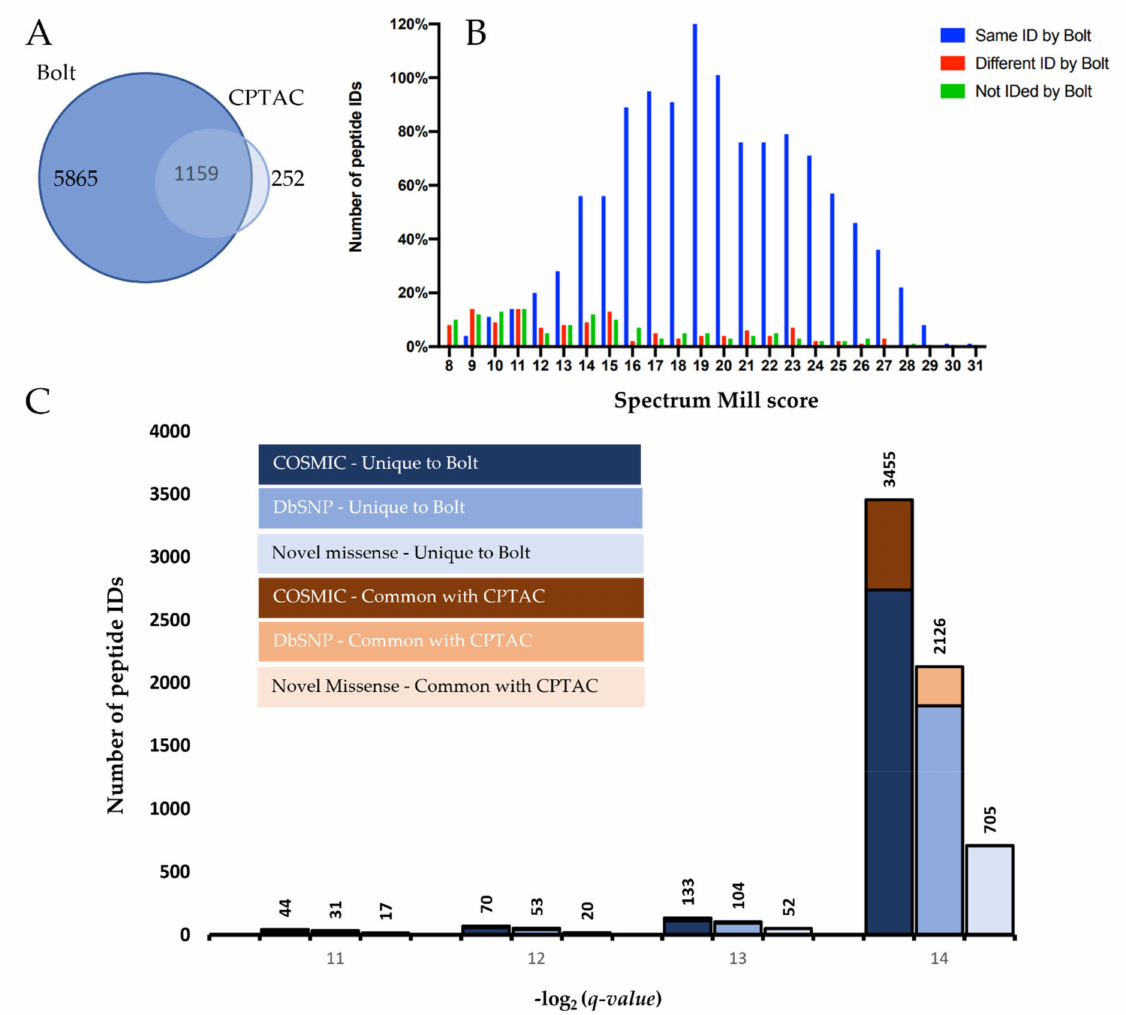
Figure 2. Comparing Bolt and CPTAC pipeline’s variant peptide IDs. ( A ) Venn diagram comparing the overall results between Bolt and CPTAC. ( B ) Spectrum Mill score distribution for the CPTAC’s peptide IDs that were also found by Bolt (blue), the peptide IDs that were matched to different spectra by Bolt (red) and the peptide IDs that were not reported by Bolt (green). ( C ) Distribution of q -values of the Bolt’s IDs that are unique as well as common with CPTAC, categorized into three categories: COSMIC, DbSNP and novel